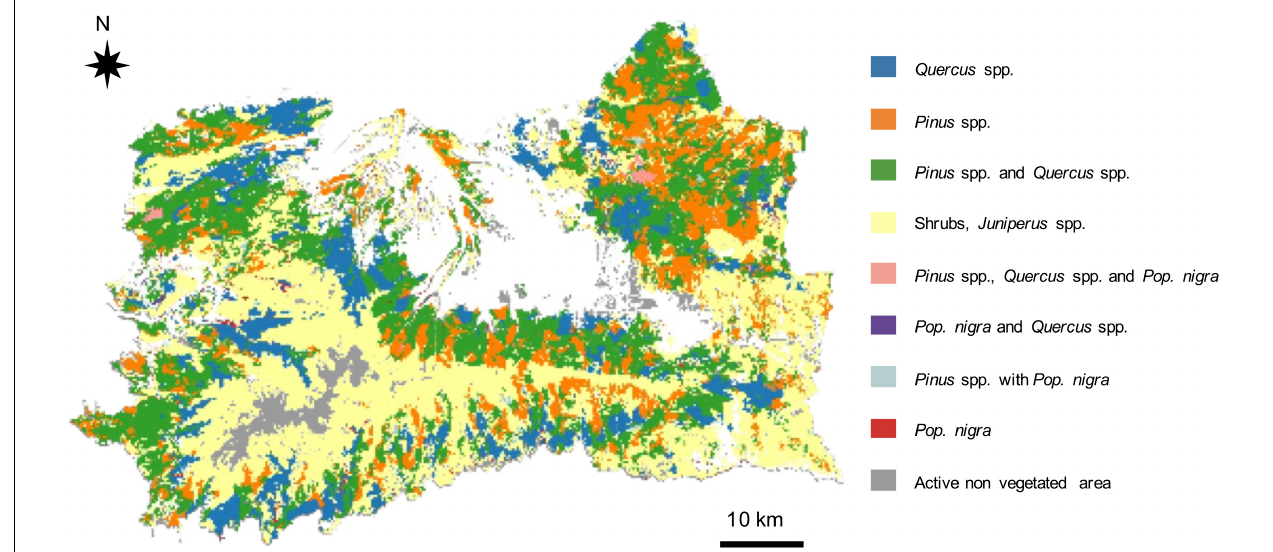
FIGURE 4 | Map of initial vegetation conditions including shrub communities. Each category represents a community dominated by one or more tree species, where shrubs and Juniperus spp. may also be present.